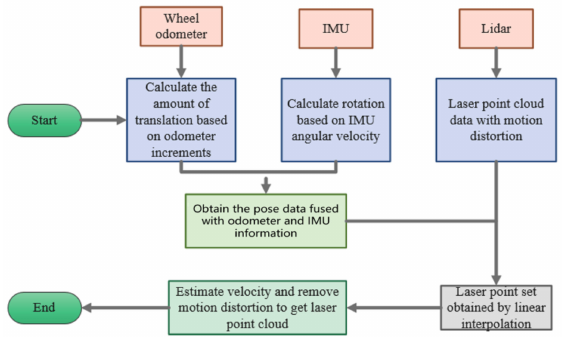
Figure 4. The architecture diagram of the Iao_ICP